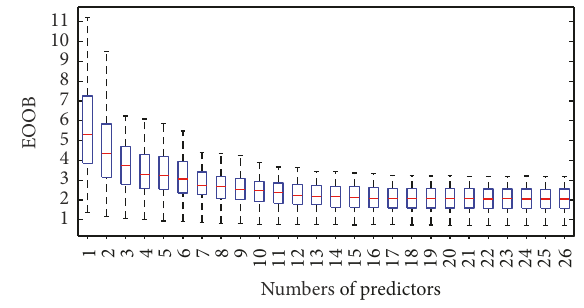
Figure 6: MSEs of out-of-bag samples.